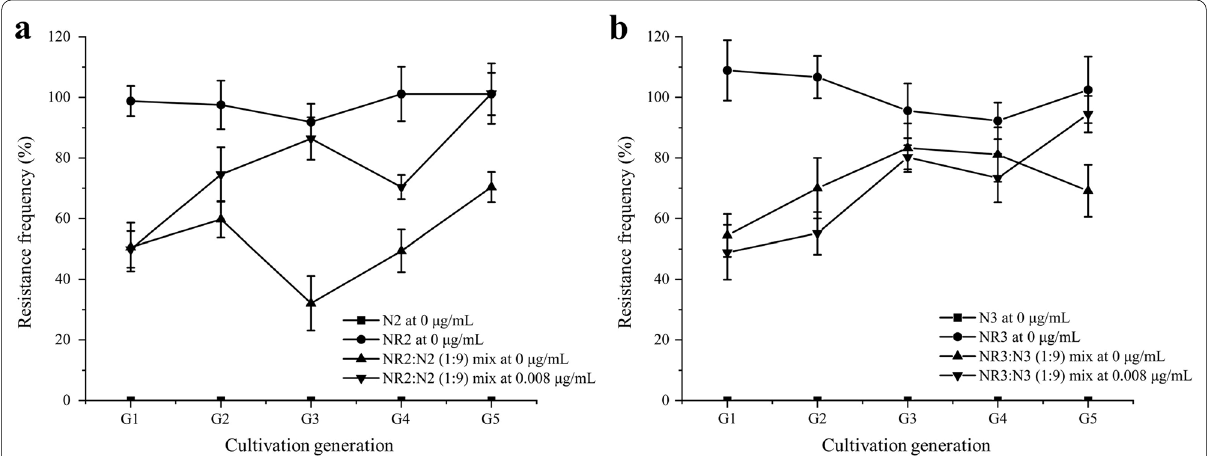
Fig. 3 Competition in vivo between ZJ0712-sensitive and ZJ0712-resistant isolates of Podosphaera xanthii with three different initial ratios and in two different pairs. a NR2/N2 pair; b NR3/N3 pair. Vertical lines indicate the standard error of the